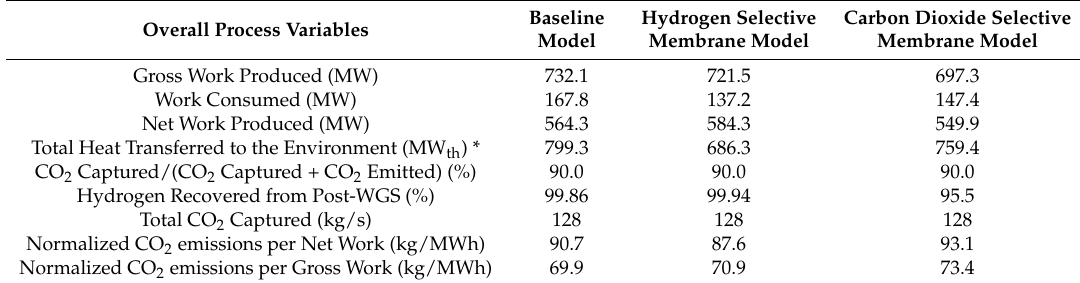
Table 12. Major differences between the baseline model, hydrogen membrane model and Carbon Dioxide Membrane